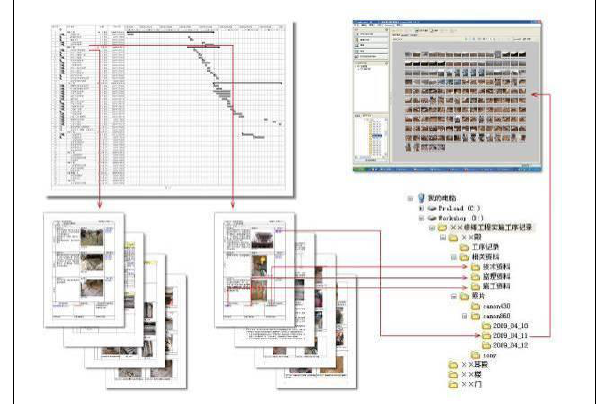
Figure 3 Data structure showing the links between the